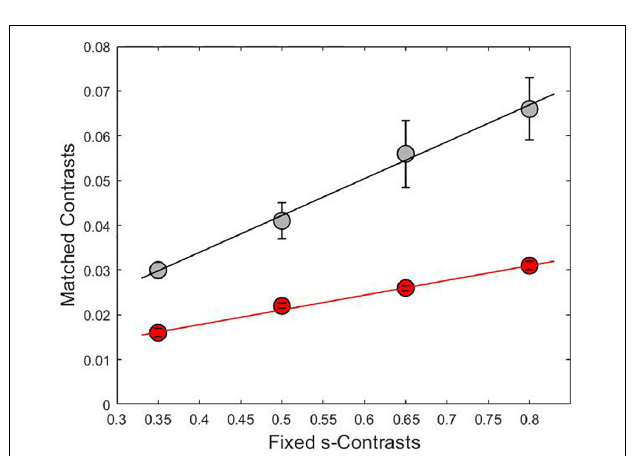
started and ended on a uniform EEW background of 20cd/m 2 .